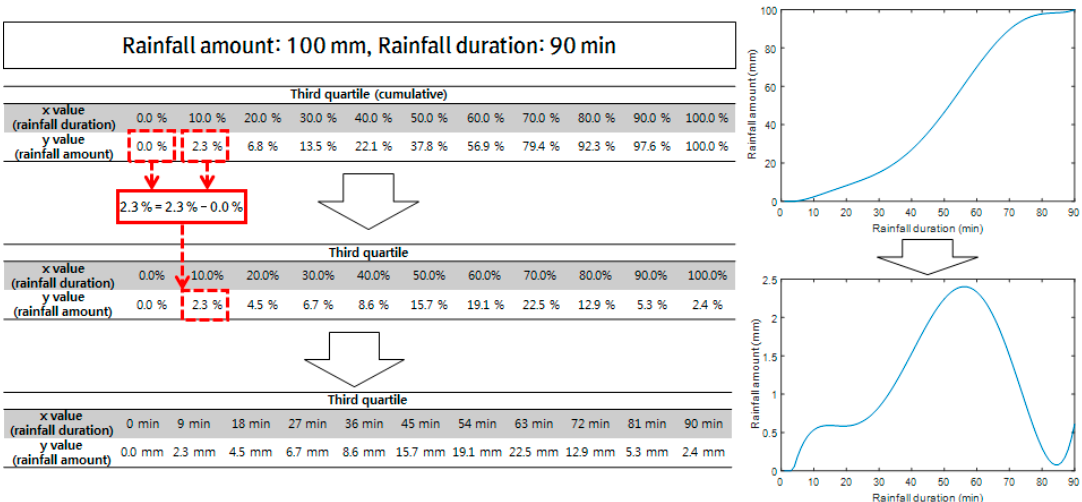
Figure 9. Generation of synthetic rainfall data by the Huff distribution.